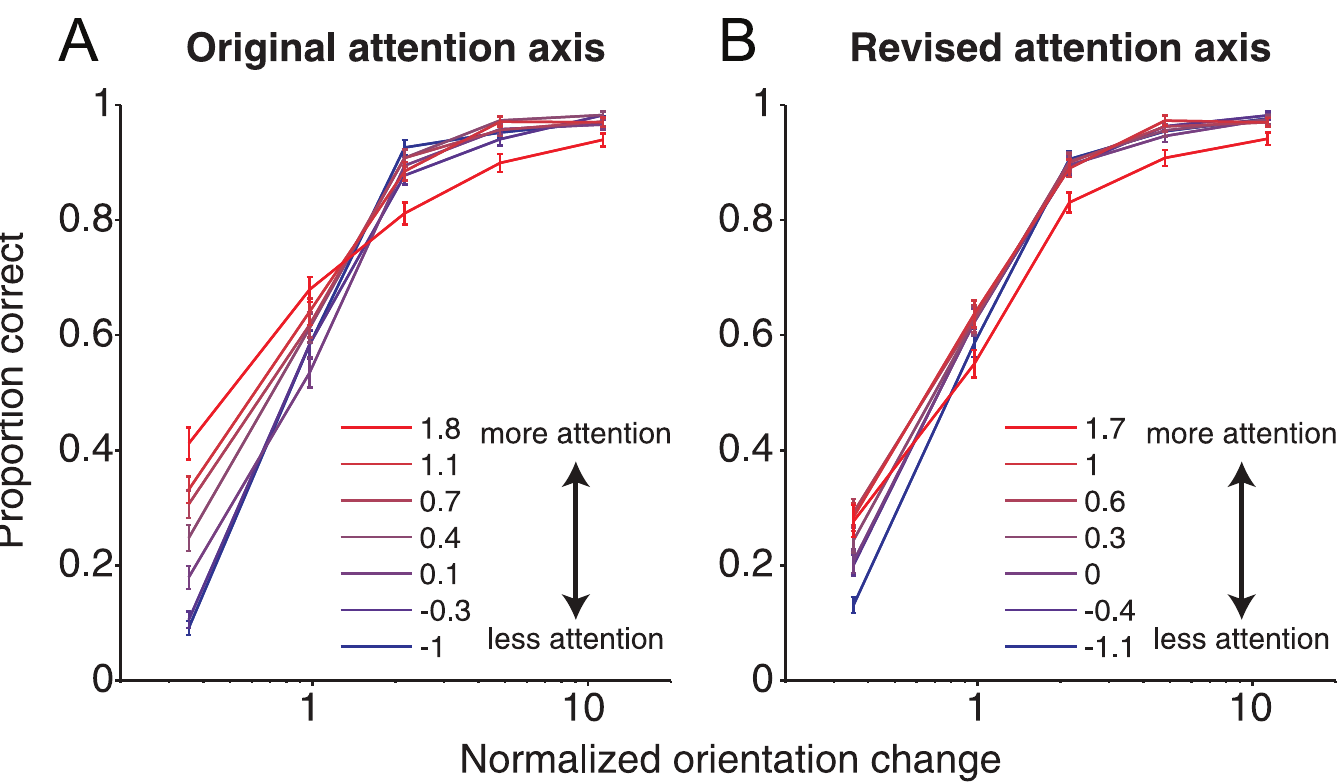
Fig 5. Psychometric curves as a function of attention axis position using the original ( A ; compare with Fig 1B from [6]) and revised (right) attention axes. Orientation changes were normalized to the behavioral threshold (63% correct) for each recording session and then binned into five equally sized bins. Trials were placed into seven equally sized bins according to position on the attention axis ranging from strong (red) to weak (blue) attentional modulation.